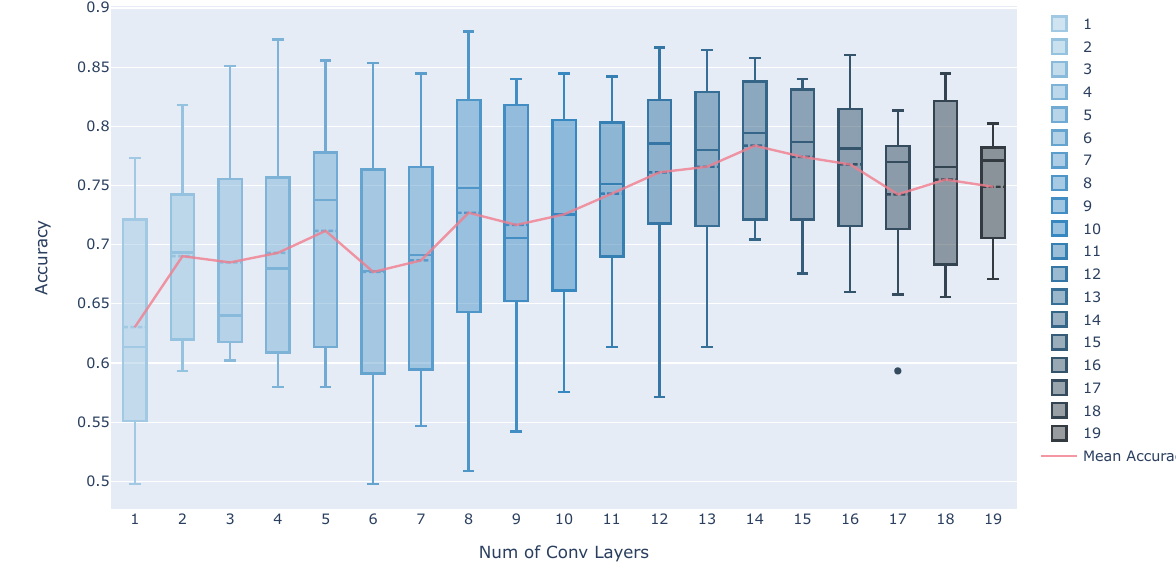
Figure 5. Estimation accuracy when the number of convolutional layers is